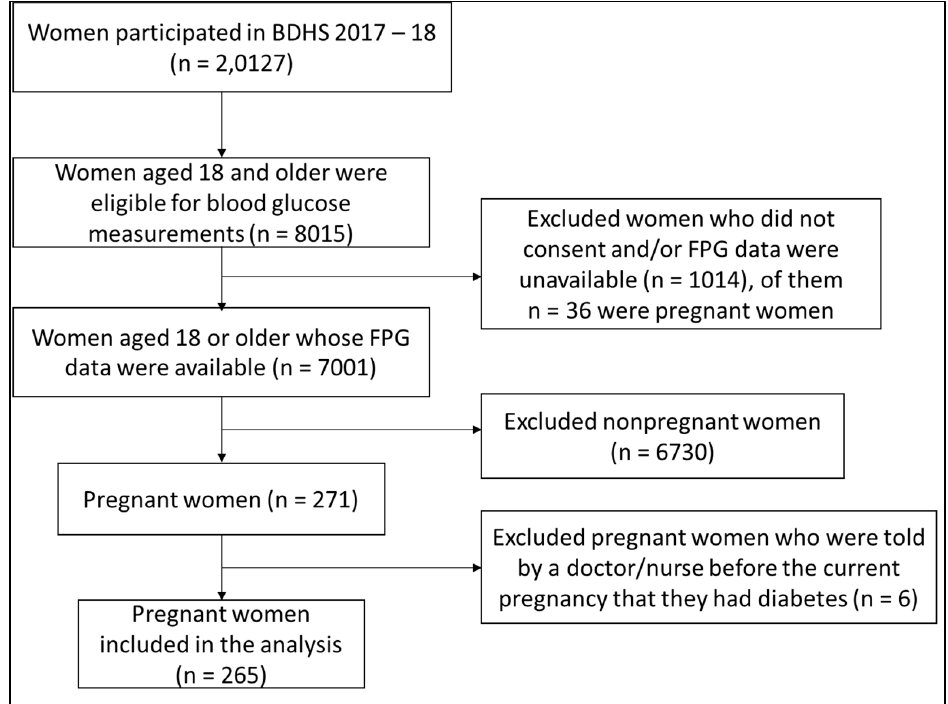
Figure 1. Flow of sample selection (unweighted). Abbreviation, FPG—fasting plasma glucose.